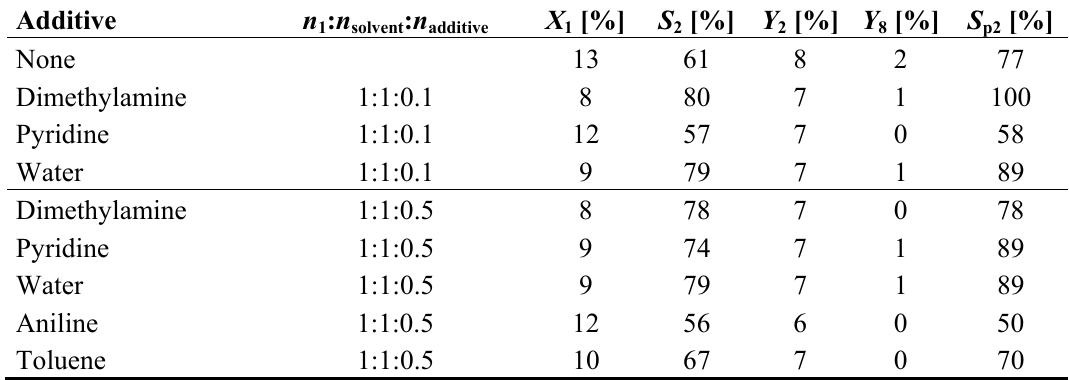
Table 2. Conversion X definition see Figure 4) for the pyrolysis of 1 with different additives at T = 450 °C a .